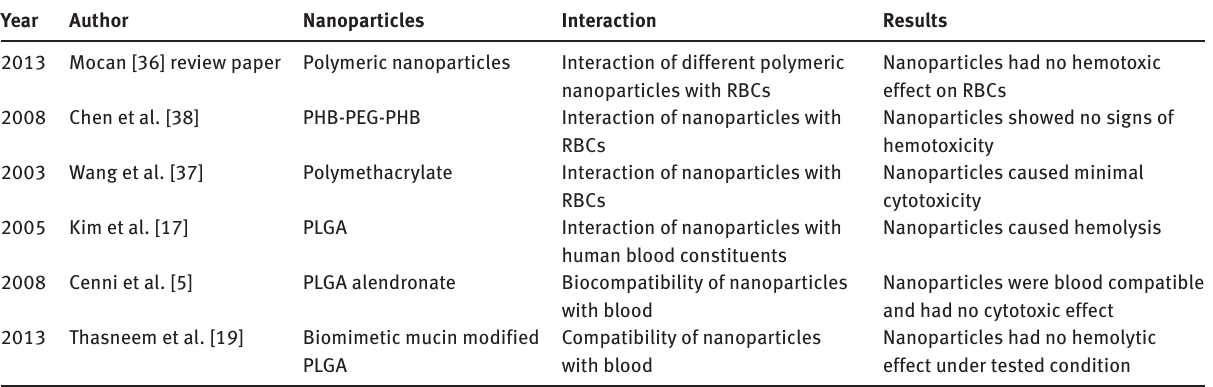
Table 3: Interaction of polymeric nanoparticles with